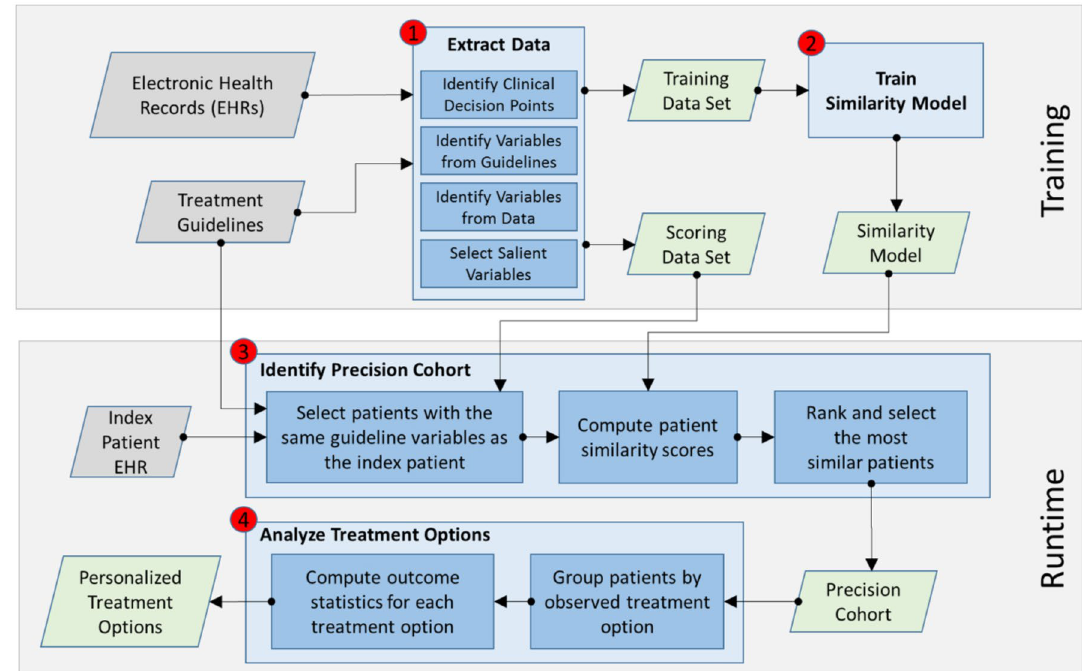
Figure 1. High-level Precision Cohort Treatment Options (PCTO) workflow. The PCTO workflow consists of four major steps: (1) data extraction, (2) similarity model training, (3) precision cohort identification, and 4)